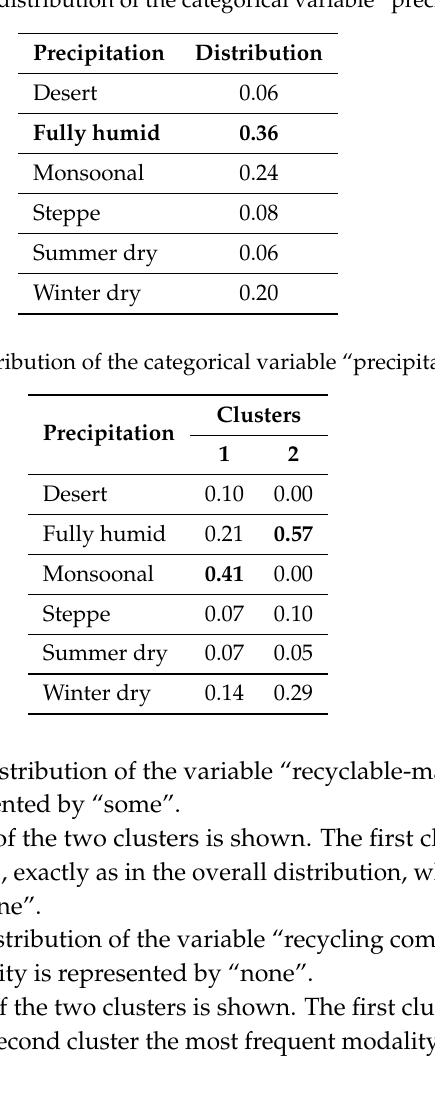
Table 11. Overall distribution of the categorical variable “precipitation”.